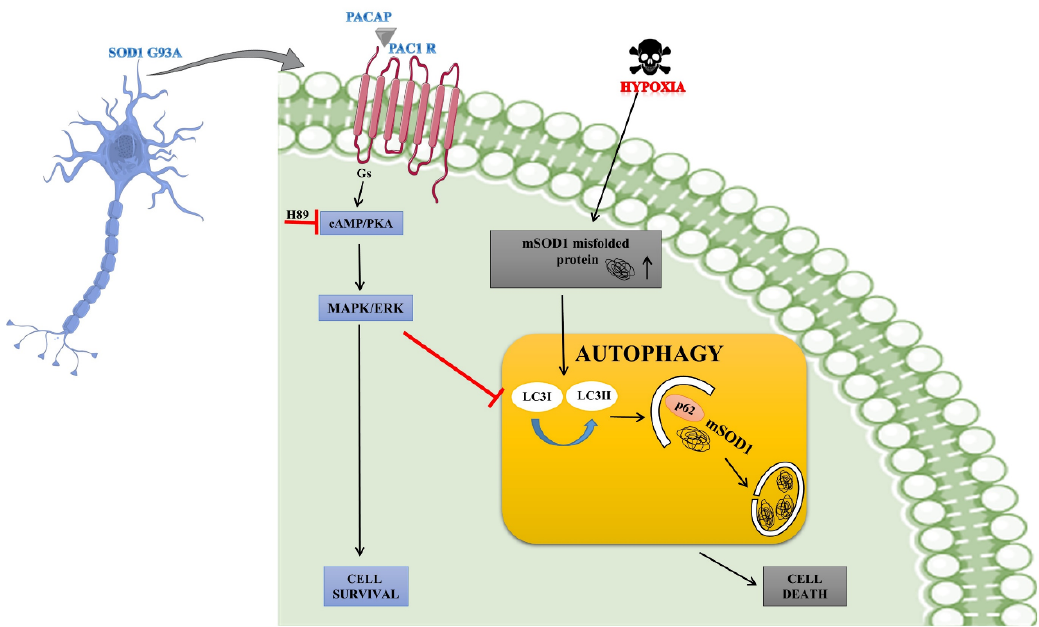
Figure 8. PACAP’s modulatory effect on the autophagy process in SOD1 G93A cells exposed to hypoxia. Hypoxia increased the misfolded mSOD1 proteins causing autophagy dysregulation and cell death. By binding to the PAC1 receptor, PACAP stimulates cAMP production triggering different downstream signaling cascades, including the MAPK/ERK pathway. PACAP-induced ERK phosphorylation regulates the autophagy hyperactivation in the mSOD1 G93A cells leading to their survival.